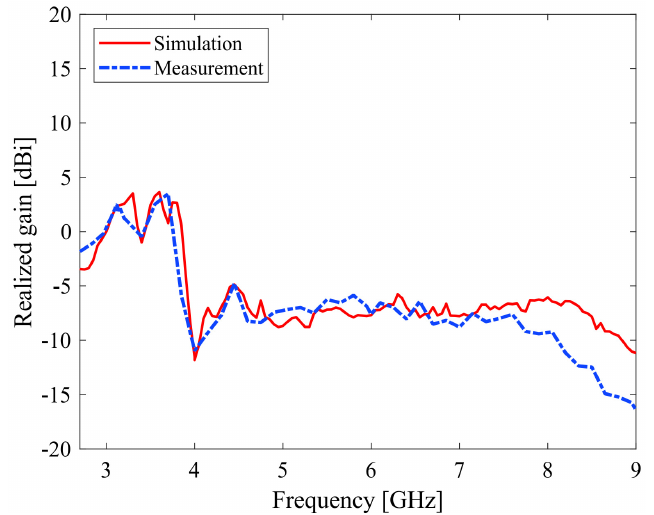
Figure 14. Comparison of the simulated and measured maximum gain of the proposed